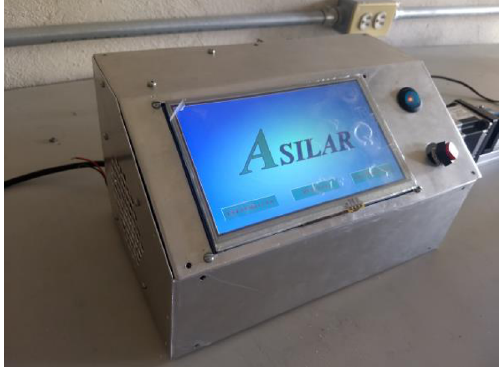
Figure 14. The metal case with the HMI touchscreen.